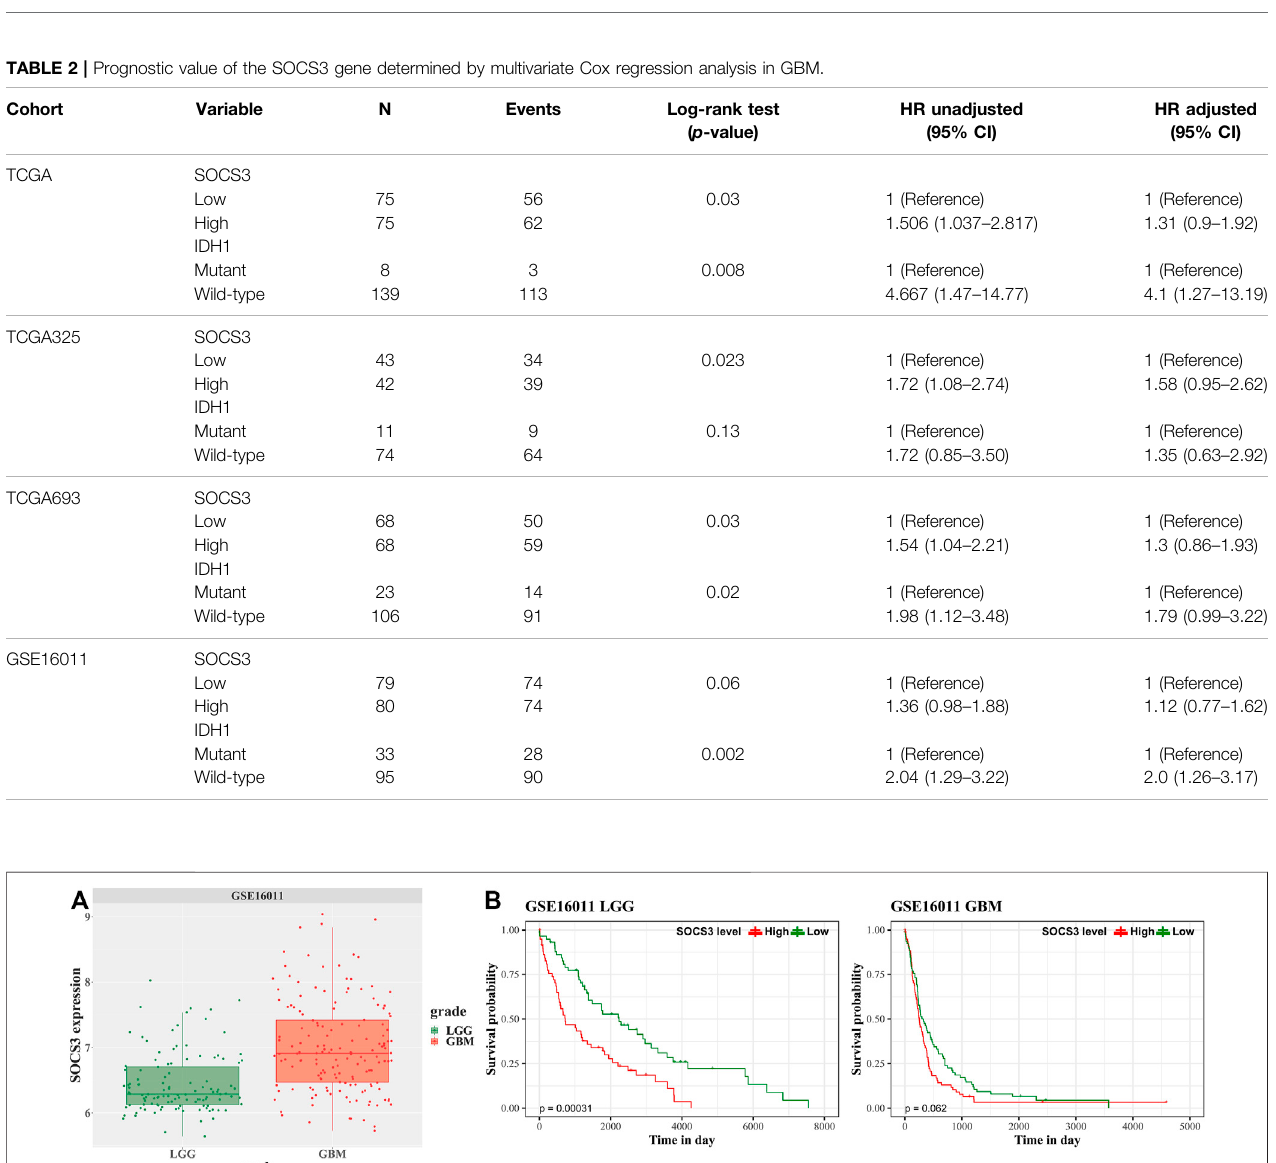
Frontiers in Genetics |